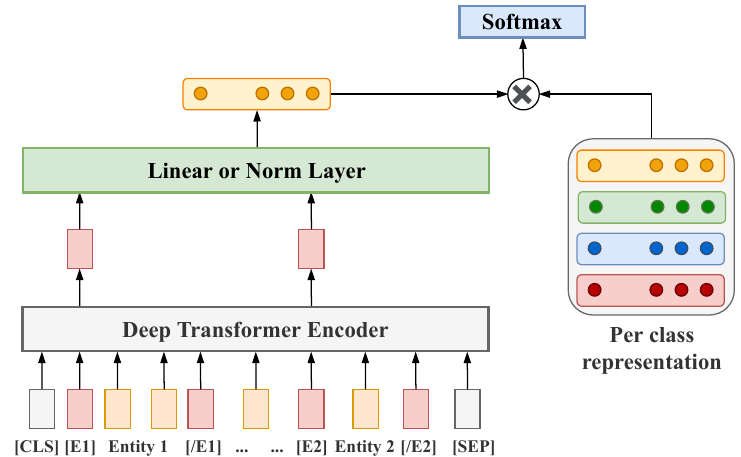
Figure 2. Relation-Based Collocation